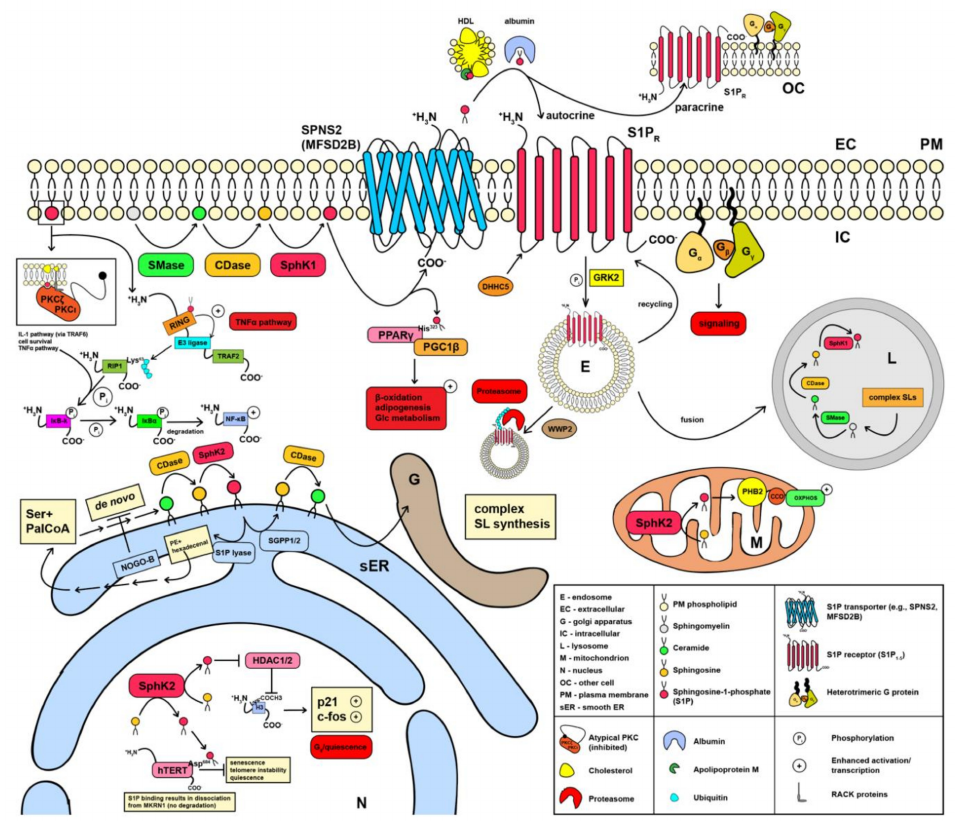
Figure 1. Sphingolipid biosynthesis, sphingosine 1-phosphate (S1P) release, and signaling. S1P is generated in different compartments within a cell. Nuclear S1P influences the balance between chromosome density by histones and telomere length impacting on metabolic adaptations and cell proliferation. De novo S1P synthesized at the smooth endoplasmic reticulum may be utilized for